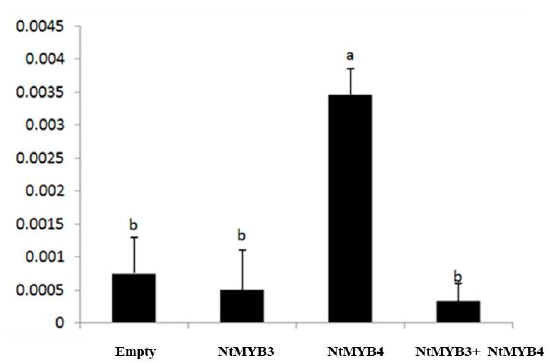
Figure 11. Dual luciferase assay confirms the repression of NtMYB3 to NtFLS promoter.